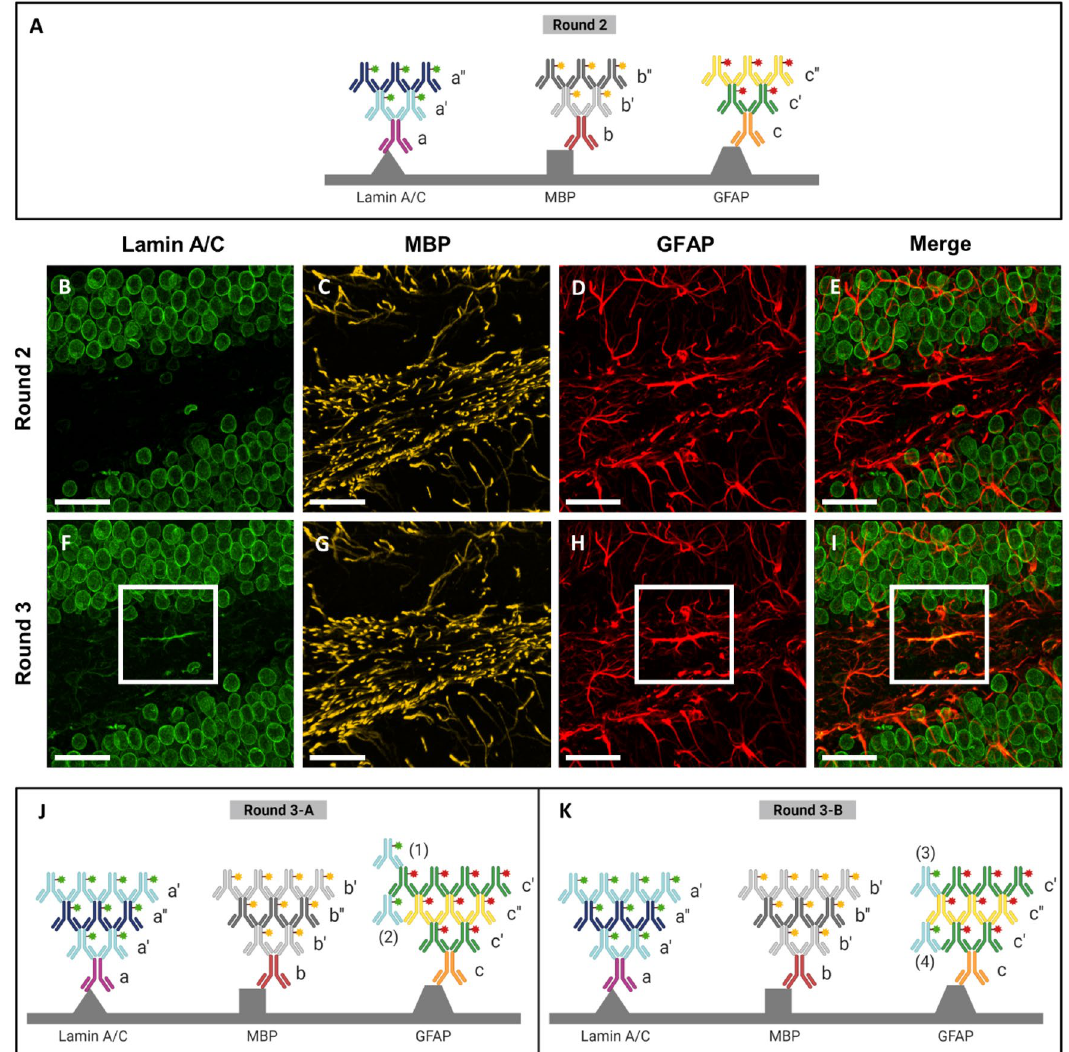
Figure 2. Cross-reaction during Round 3 of staining. ( A ) Schematics of the antibody layers in Round 2. ( B )– ( E ): Round 2 images, with no cross-reaction observed between lamin A/C and GFAP channel. ( B ) lamin A/C, Round 2. ( C ) MBP, Round 2. ( D ) GFAP, Round 2. ( E ) Merge of Fig. 1B,D. ( F – I ): Round 3 images, with cross- reaction observed between lamin A/C and GFAP channel. ( F ) lamin A/C, Round 3. ( G ) MBP, Round 3. ( H ) GFAP, Round 3. ( I ) Merge of Fig. 1F,H. ( J ) Schematics of the first potential cross-reaction during Round 3. ( K ) Schematics of the second potential cross-reaction in Round 3. For ( B – I ), the scale bar is 30 µ